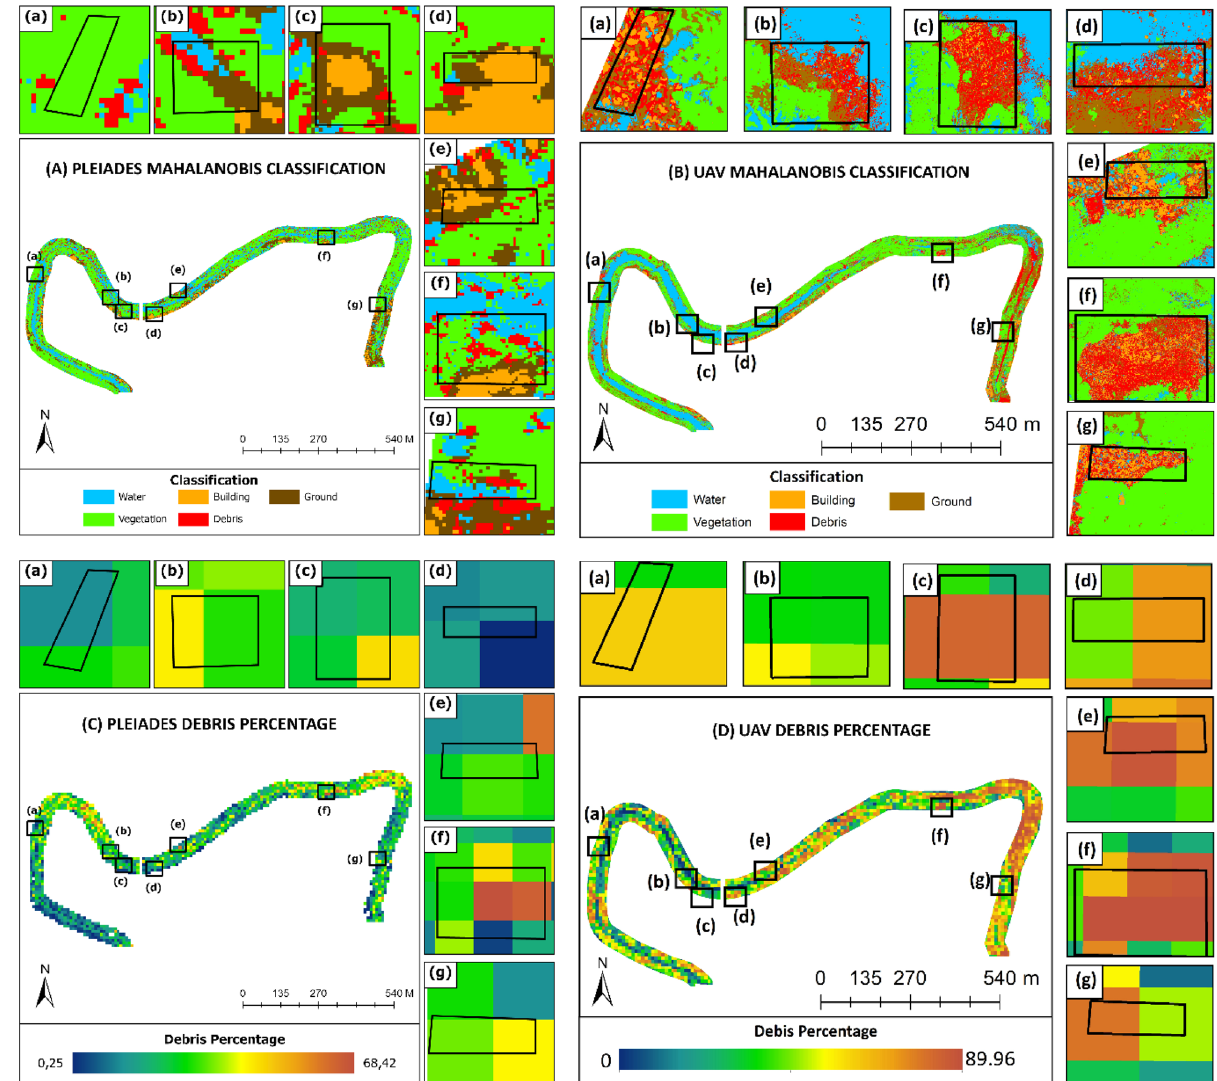
pixel size of 10 × 10 and the percentage of debris on (C) Pleiades imagery and (D) UAV